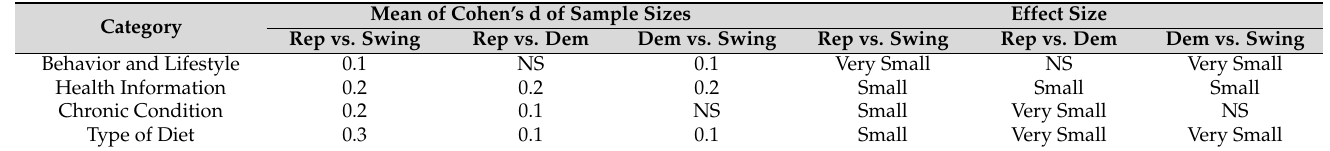
Table 7. Cohen’s d and effect size of comparisons in Table 6.